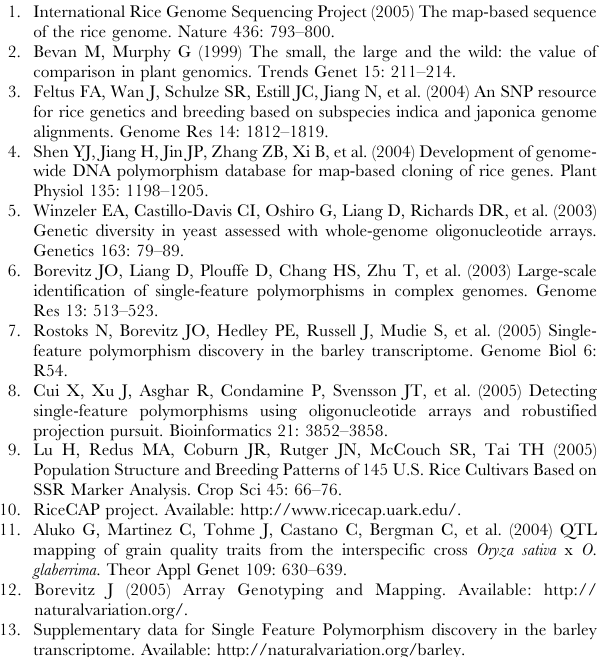
Table S1 Sequence verified SFPs in CP& LG dataset. Changes in sequences are highlighted in blue and black; - indicates deletion; CP = Cypress and LG= LaGrue.